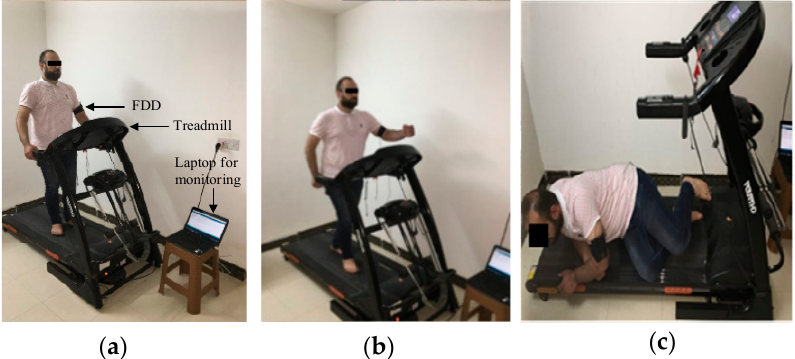
Figure 7. Scenario to evaluate the performance of the FDB-HRT algorithm, with three stages of ( a ) Standing, ( b ) Running, and ( c ) Falling.